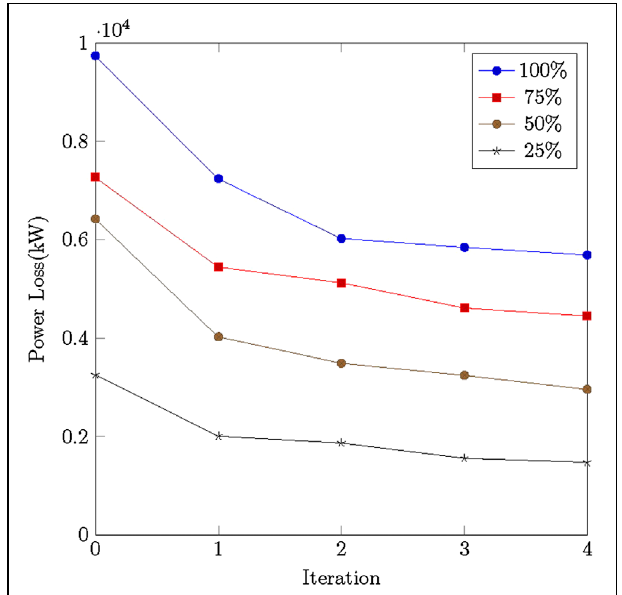
FIGURE 4 | Optimization results under different wind turbine output level during iterations.